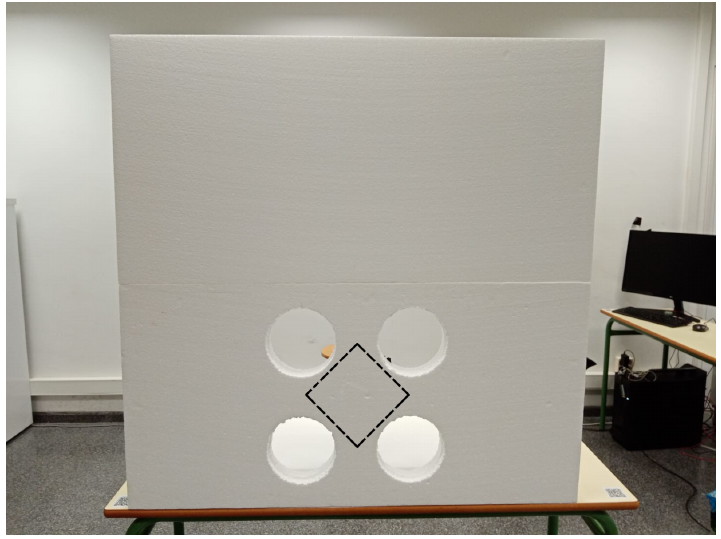
Figure 3. The styrofoam calibration board has black dashed lines that indicate the location of the corner reflector, which was placed in the center of the back of the board.